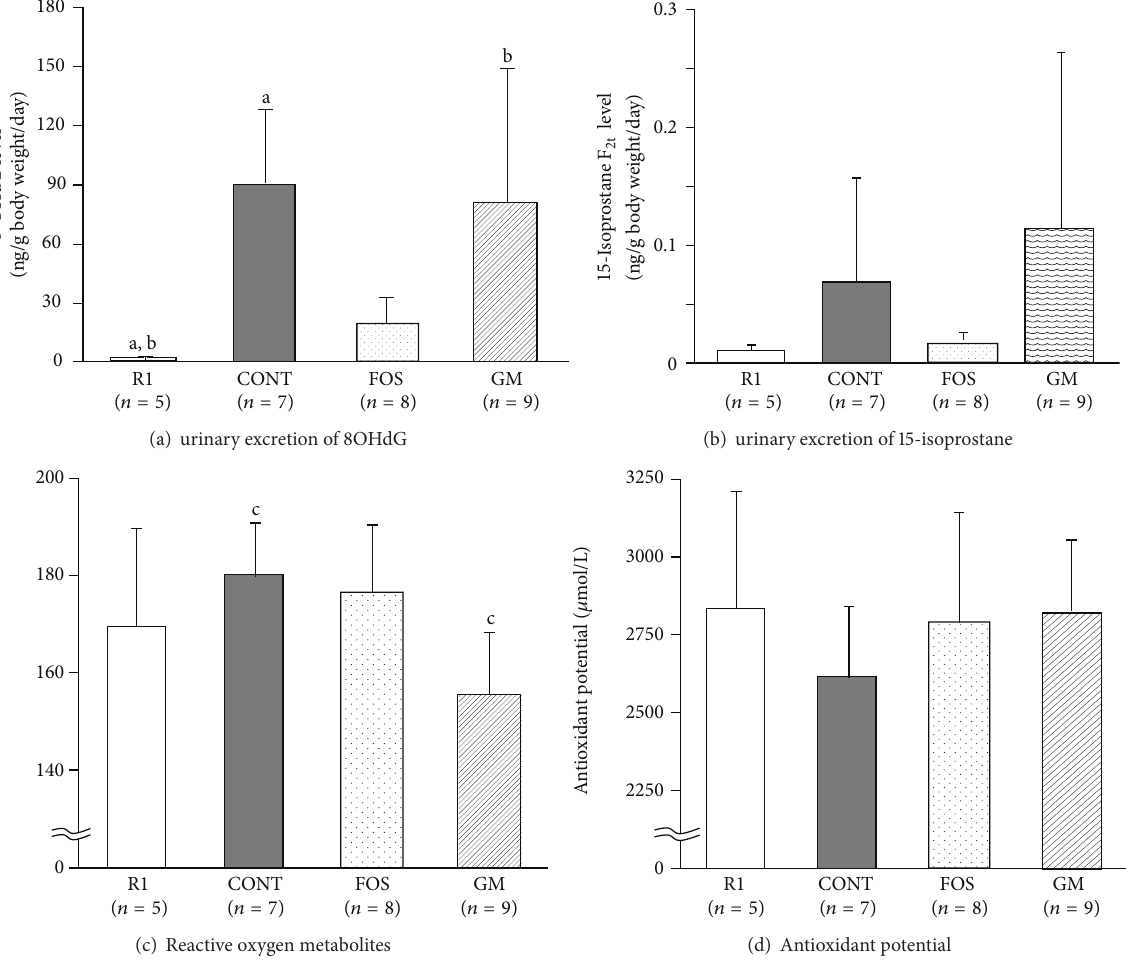
Figure 5: Effect of FOS or GM feeding on oxidative stress and antioxidant markers in urine and serum at 38 weeks after feeding. Values were expressed as mean ± SD. R1, SAMR1, and control diet; CONT, control diet; FOS, 5% of fructooligosaccharide diet; 5% of GM,